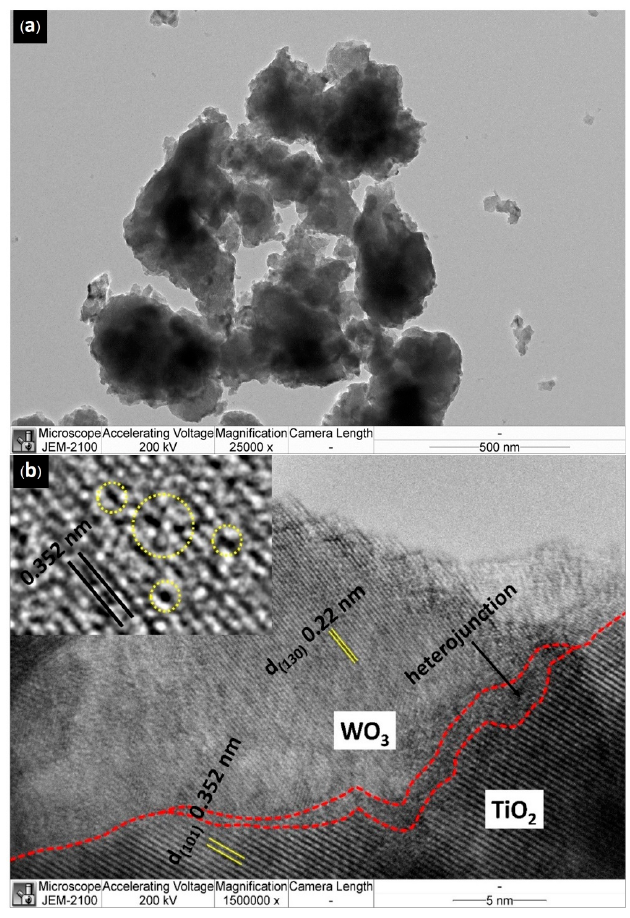
Figure 4. TEM images of the composite metal oxides (10%WO 3 @TiO 2 ) at low magni fi cation ( a ) and high magni fi cation ( b ).